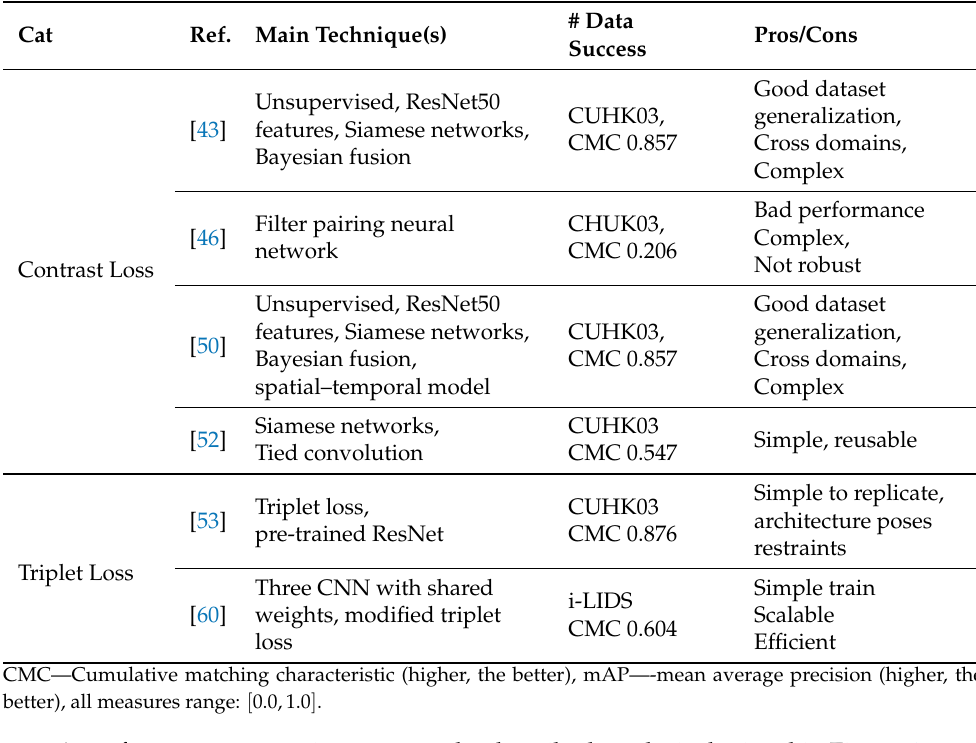
Table 3. Performance evaluation of the reviewed person ReID using deep metric methods.